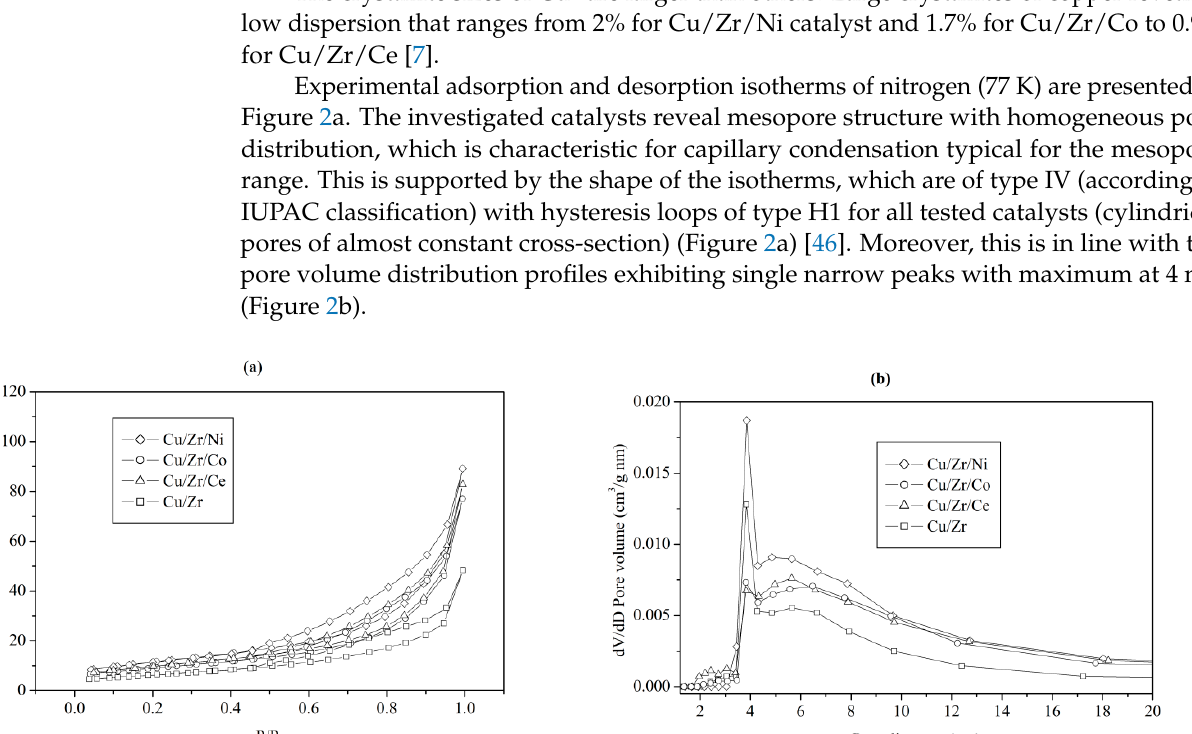
Table 1. An addition of an oxide of Ce, Co, or Ni to Cu/Zr catalyst results in